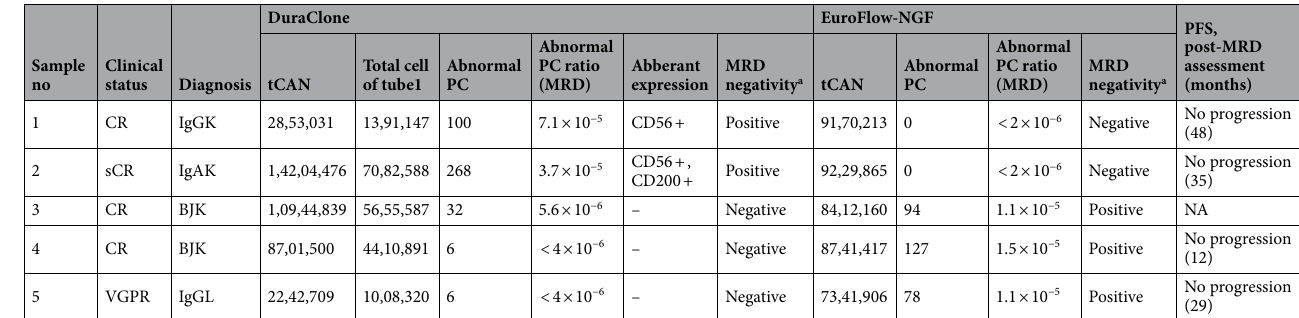
Table 2. Overview of the samples showing discrepancy of MRD negativity between DuraClone and EuroFlow-NGF methods. tCAN total cell acquisition number, PC plasma cells, MRD minimal residual disease, NGF next-generation flow, CR complete response, sCR stringent CR, VGPR very good partial response, PFS progressionfree survival, NA not assessed due to be transferred to another hospital. a The thresholds of MRD negativity was 1 × 10 −5 in both DuraClone and